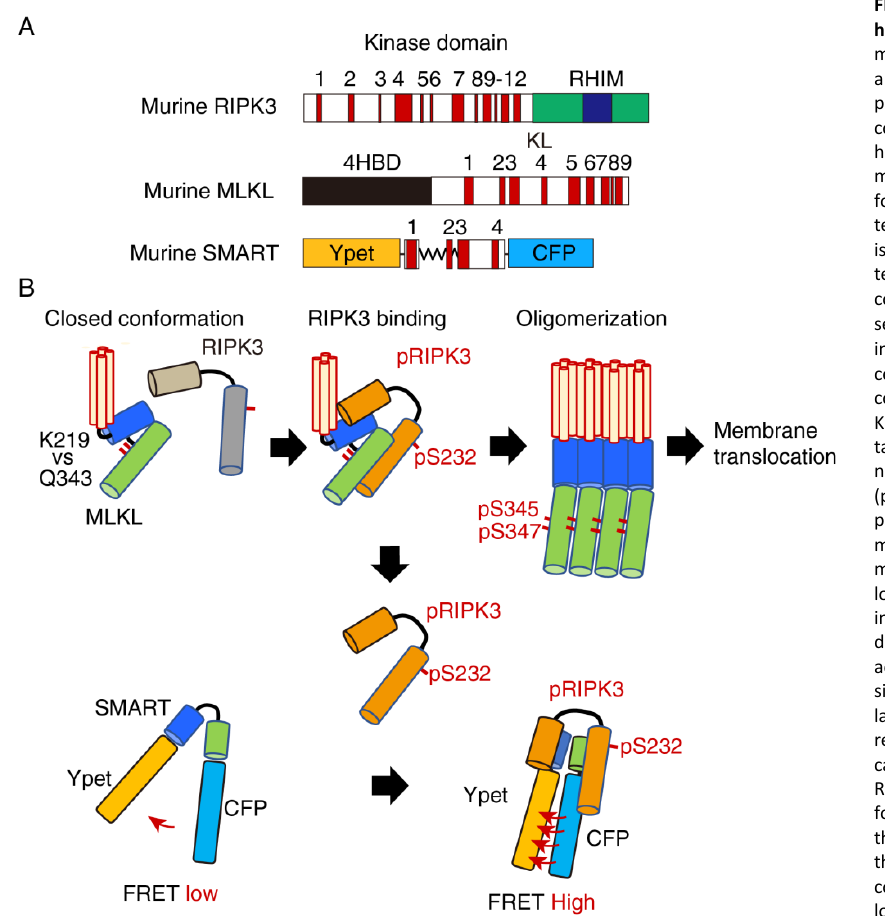
FIGURE 1: A model for the mechanism how SMART senses necroptosis. (A) Do- main structures of murine RIPK3, MLKL, and diagram of SMART. mRIPK3 is com- posed of N-terminal kinase domain that contains twelve helices and C-terminal RIP homotypic interaction motif (RHIM) do- main. mMLKL is composed of N-terminal four helices bundle domain (4HBD) and C- terminal kinase-like (KL) domain. mSMART is composed of N-terminal Ypet and C- terminal CFP where a modified fragment containing  1 to 4 helices of MLKL is in- serted in the intervening region. Numbers indicate each  helix. (B) In unstimulated cells, endogenous MLKL adopts an inactive conformation via hydrogen bond between K219 and Q343, thereby suppressing spon- taneous oligomer formation. Following necroptosis induction, activated RIPK3 (pRIPK3) binds to MLKL, resulting in phos- phorylation of MLKL that induces